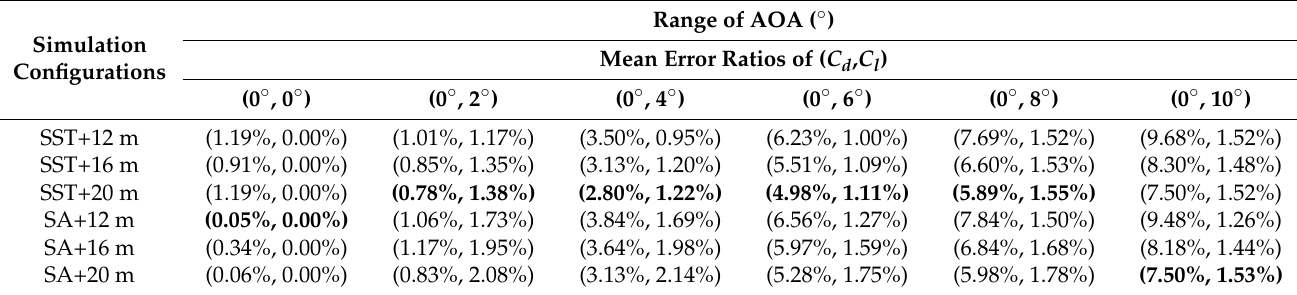
Table 9. The mean error ratios of C d and C l of the sharp trailing edge based on NACA4-digital generator.